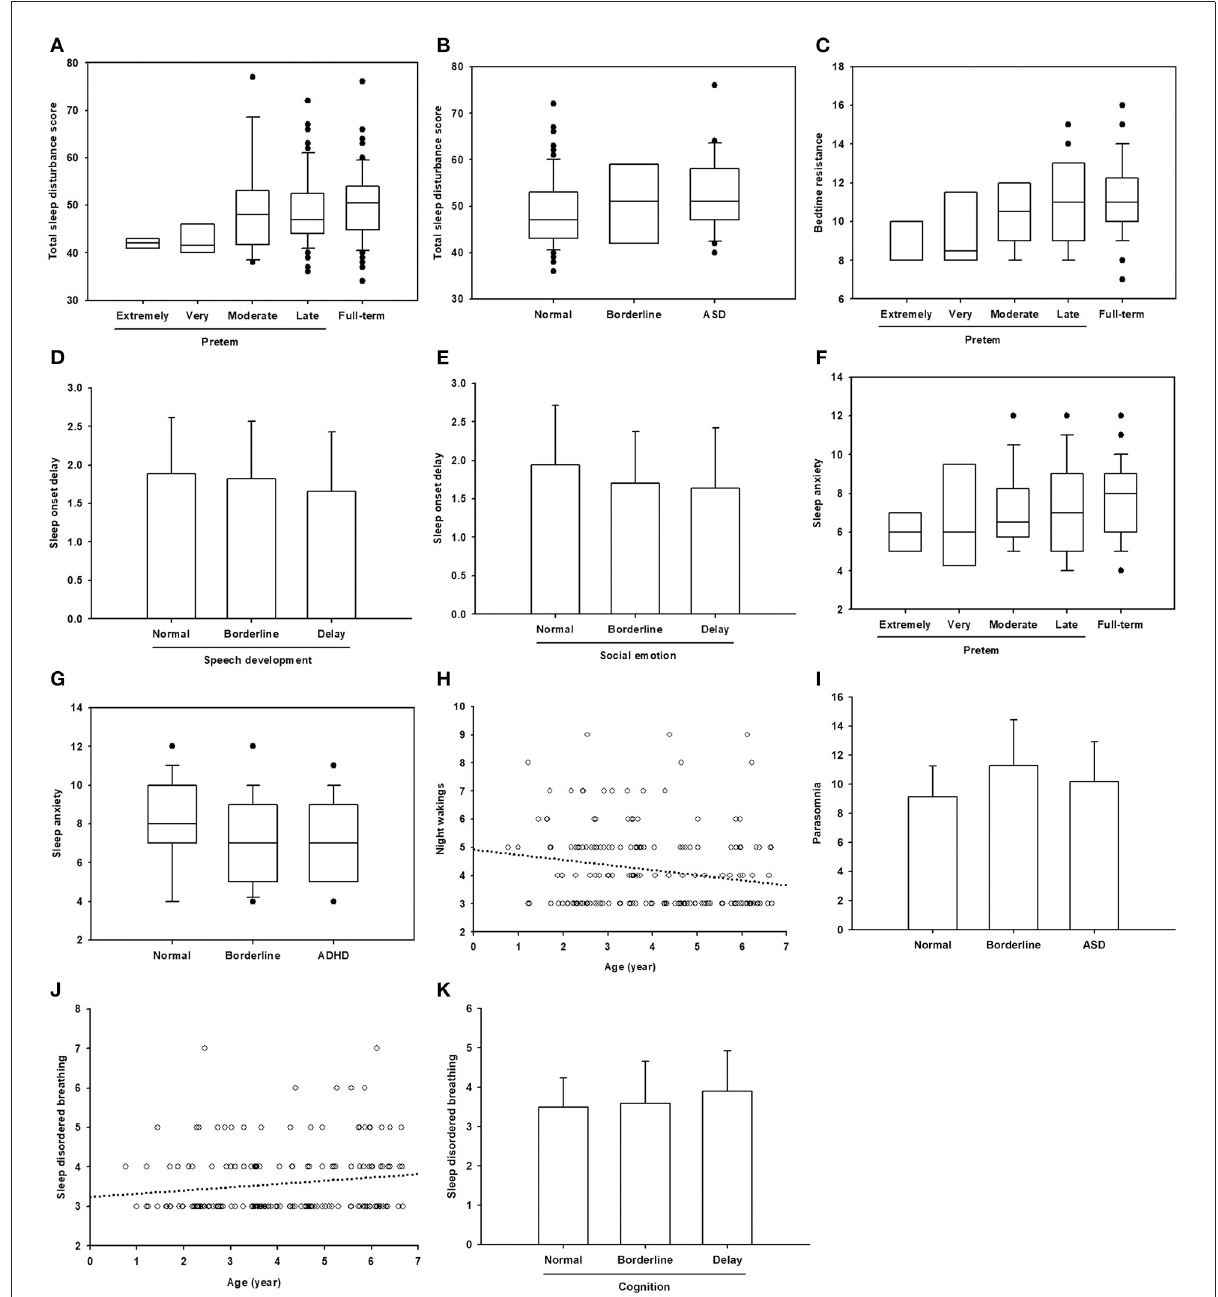
FIGURE2 Significant correlations between age, gestational age, and neurodevelopmental status with sleep problems. (A–C,F,G) Data are presented in box plot. Within each box, a horizontal line denotes median value. Boxes extend from the 25th to the 75th percentile of values. Dots denote outliers. (D,E,I,K) Data are presented as mean ± standard deviation. (H,J) The circles represent the plotted values while the line represents the best fit for the correlation between the two